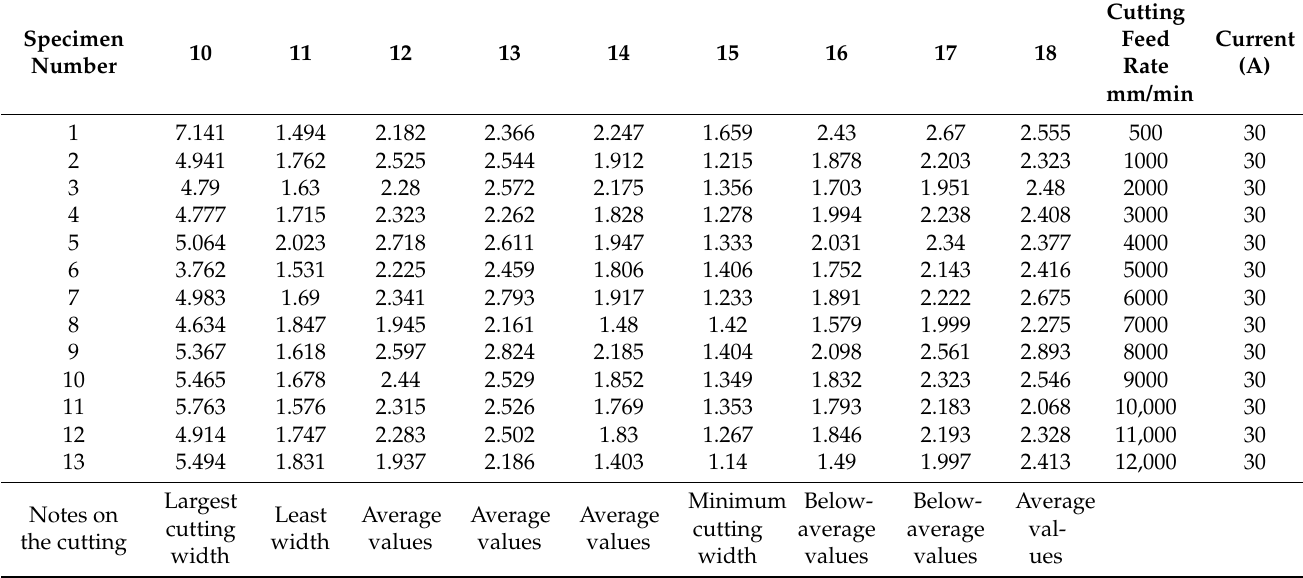
Table 6. Show the values of the cutting path width readings generated by cutting specimens through the operating factor values used in the PAC experiments, in which the kerf width points are labeled